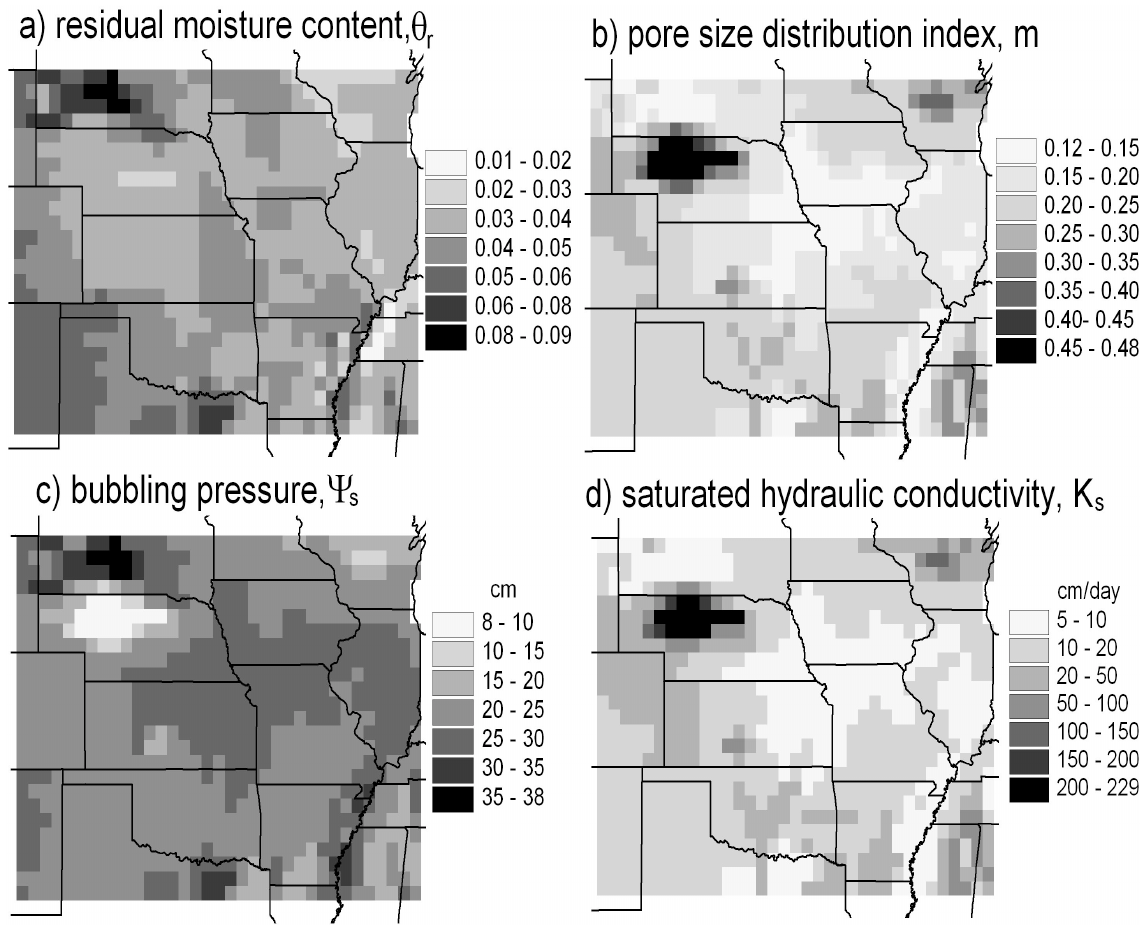
Fig. 13. Root-zone estimates of (a) residual moisture content, (b) pore size distribution index, (c) bubbling pressure, and (d) saturated hydraulic